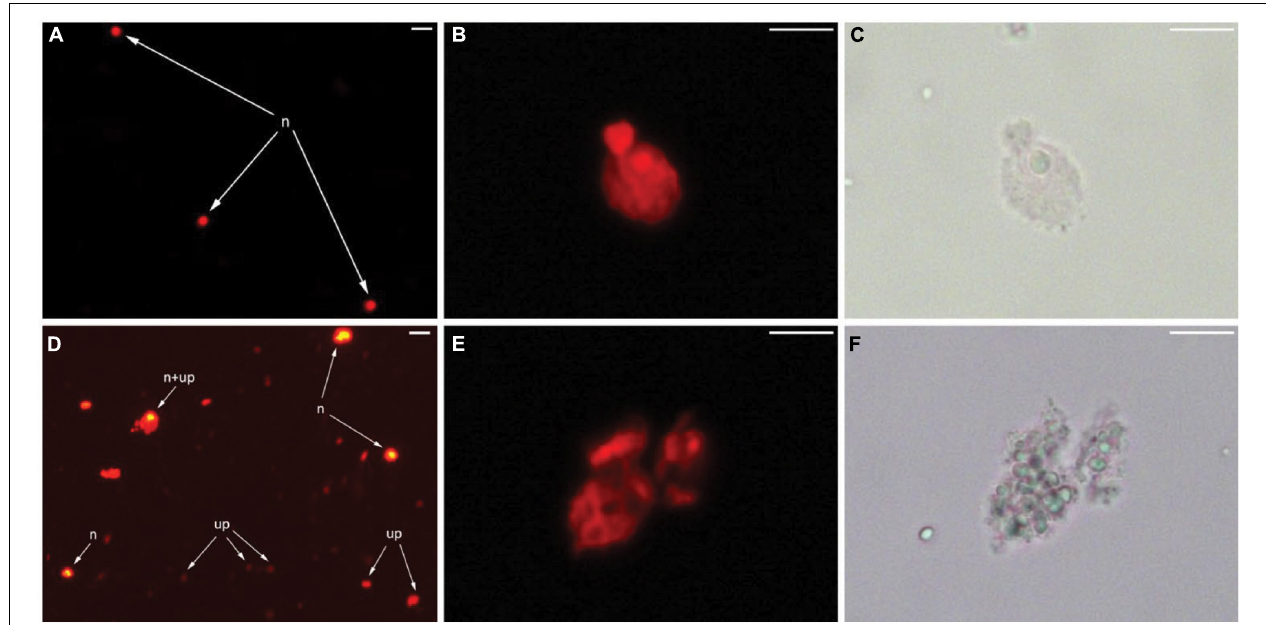
FIGURE 4 | Micrographs of tomato leaf and grapevine bud nuclei suspensions under light and epiluminescence microscope. A fluorescence image of debris-free nuclei (n) prepared from tomato young leaves (A) . Higher magnification of a single nucleus of tomato by fluorescence (B) and bright-field (C) illumination. Overexposed fluorescence image of grapevine bud nuclei suspension showing debris particles with weak fluorescence (up), debris aggregated with nuclei (n + up), and debris-free nuclei (n) (D) . Higher magnification of a single nucleus of grapevine by fluorescence (E) and bright-field (F) illumination. Bar = 20 µ m (A,D) , 10 µ m (B,C,E,F)